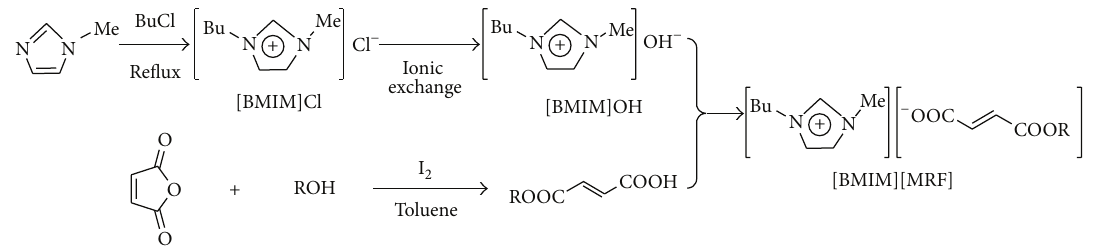
Scheme 2: Synthesis of ILs with fumarate